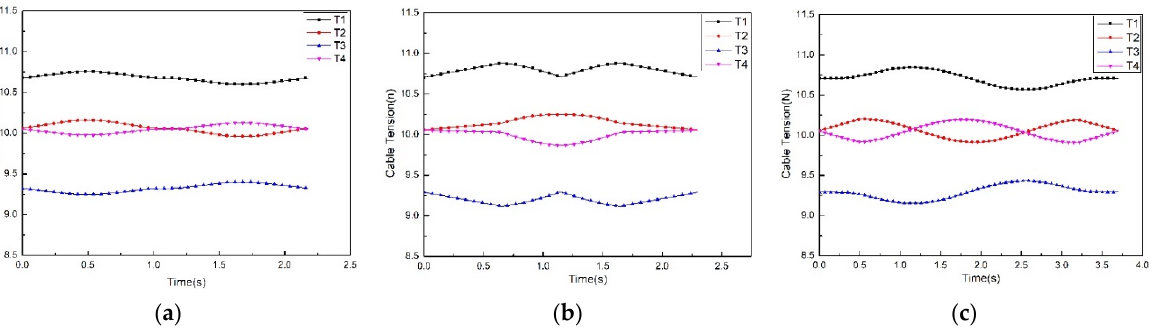
Figure 11. Variation curve of cable tension under continuous change in cable exit point position. ( a ) Linear motion trajectory; ( b ) Parabolic motion trajectory; ( c ) Circular motion trajectory